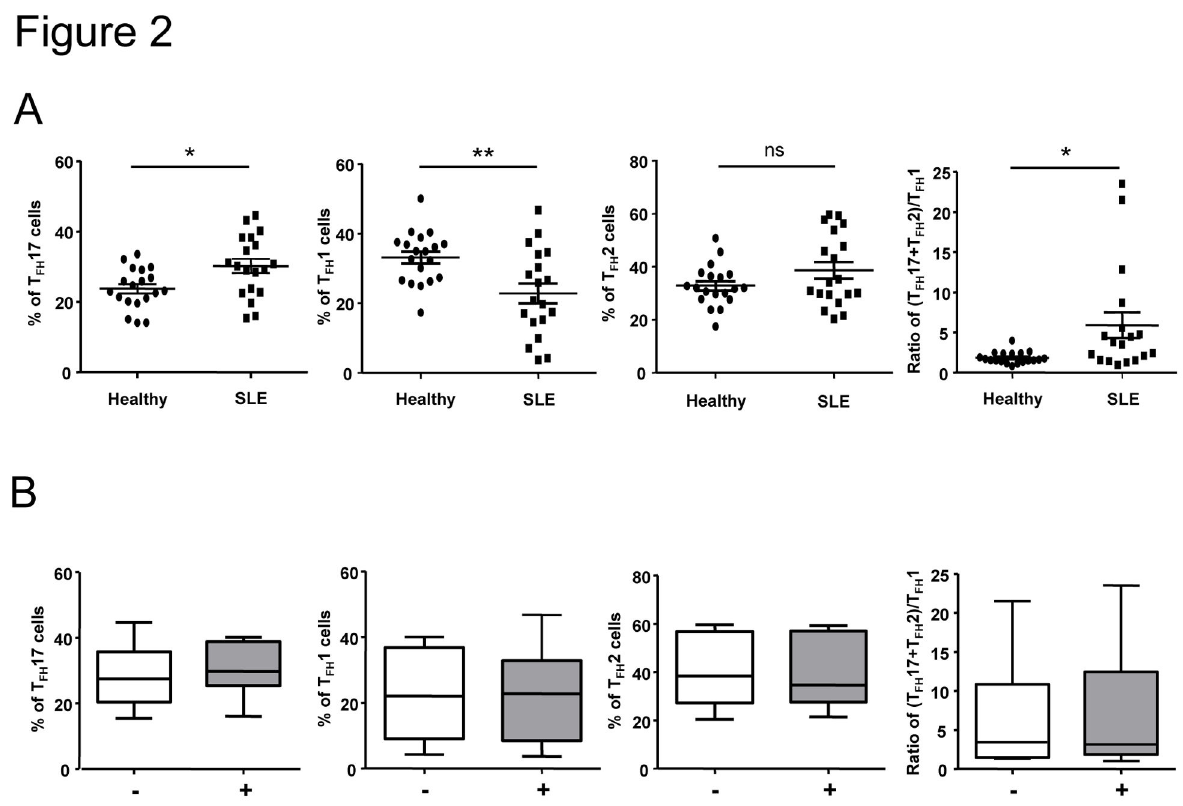
Figure 2. T cell subset distribution is altered in SLE patients. PBMCs from SLE patients (n = 19) and sex and age-matched FH healthy controls (n = 19) were stained for CD4, CD45RA, CXCR5, CXCR3 and CCR6. The frequency of each T as the calculated (T 17+T 2)/T 1 ratio are represented (A). Each data point represents an individual subject; horizontal lines FH FH FH show the mean ± sem. Percentages of each T cell subset and the ratio of (T FH steroid treatment (-, white box, n = 8 and +, grey box, n = 6) are represented (B). * p < 0.05, ** p < 0.01 (Mann-Whitney U test). doi: